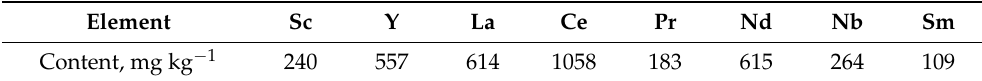
Table 3. Contents of REEs in the RM-ESPD. Element Sc